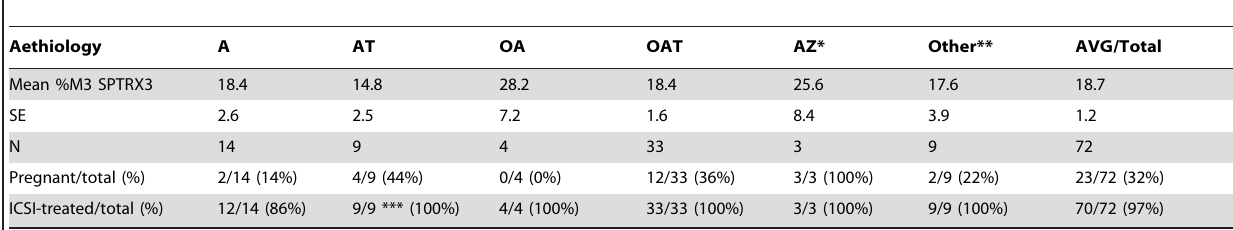
Table 3. SPTRX3 levels and ART outcomes in 72 male infertility patients divided by